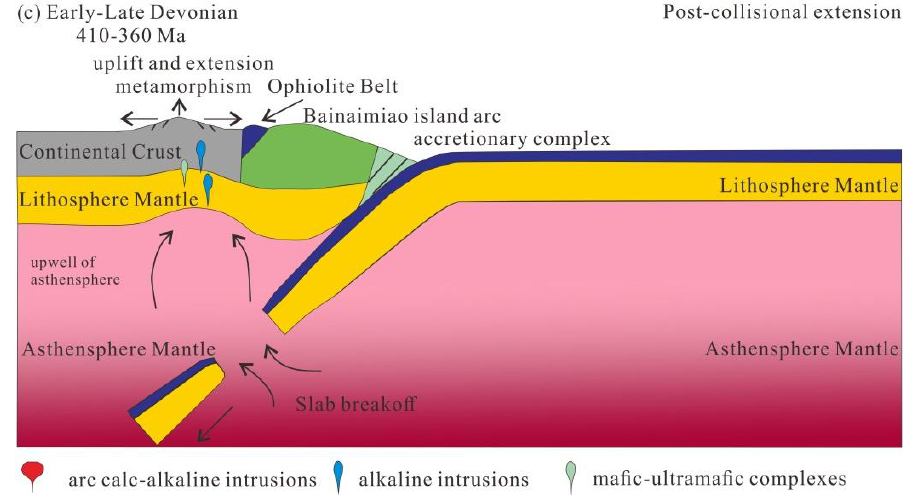
Figure 7. Simplified cross-sections illustrating the tectonic evolution of the northern margin of the NCC. ( a ) Ordovician-Silurian, the southward subduction of the Paleo Asian Ocean lithospheric plate; ( b ) Early Ordovician, the collision between the Bainaimiao arc and the NCC, the lithosphere mantle thickened, and Jianshan Formation went through regional metamorphism at c. 412 Ma; and ( c ) Early-Late Devonian, post-collision extension, Jianshan Formation, and associated monzogranites were metamorphosed at c. 397–389 Ma.